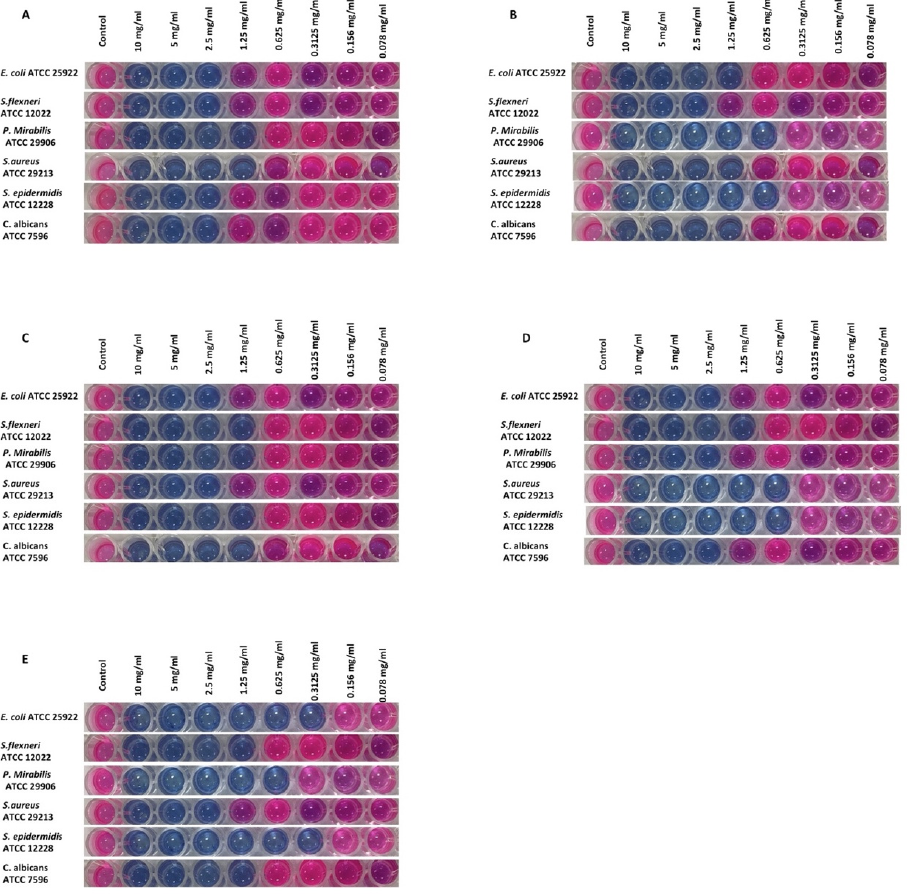
Figure 4. Effect of various propolis extracts with Hex = hexane solvent. ( A ) Eac = ethyl acetate solvent, ( B ) BuT = butano solvent, ( C ) Met = methanol solvent, ( D ) CTL = Dimethyl sulfoxide (DMSO) as control, and ( E ) against microbial strains.